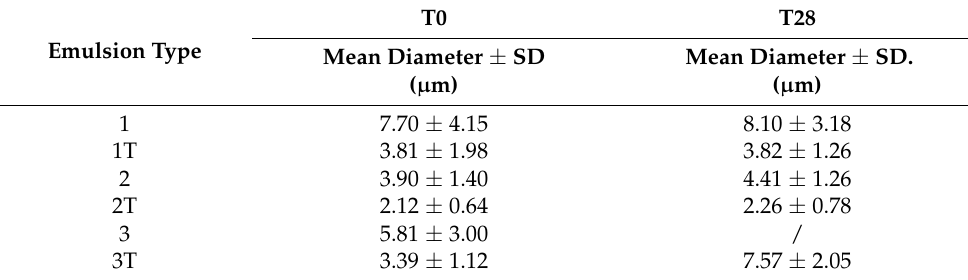
Table 2. Mean diameters ± SD (µm) measured at T0 and T28.